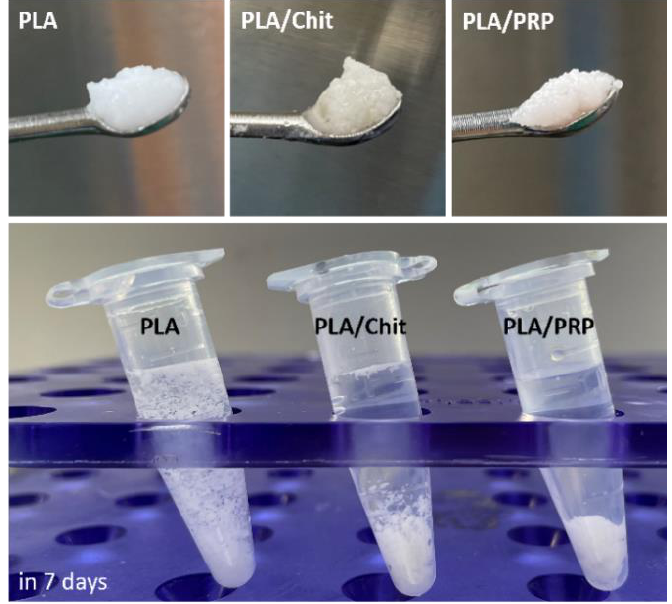
Figure 1. Matrices based on PLA granules, PLA/Chit hydrogel and PLA/PRP hydrogel in saline solution.